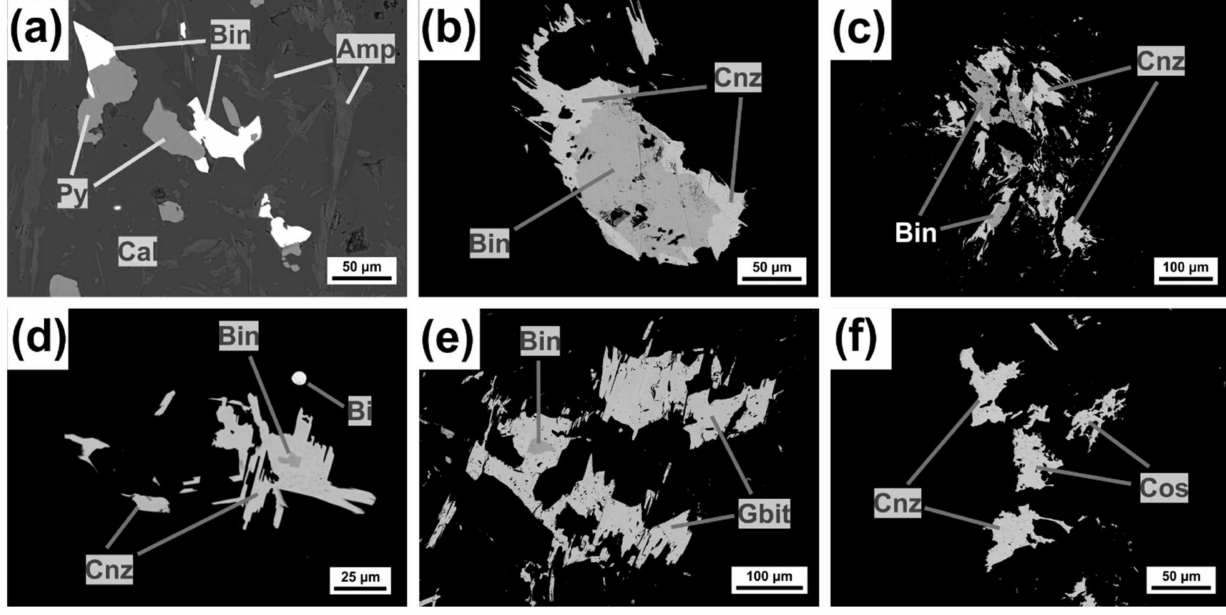
Figure 16. Back-scattered electron (BSE) images showing Bi sulfosalts from the Kizhnica hornfels: ( a ) bismuthinite overgrowing pyrite aggregates in hornfels matrix composed of calcite and amphibole; ( b ) cannizzarite overgrowing bismuthinite; ( c ) aggregate of cannizzarite with bismuthinite; ( d ) euhedral cannizzarite crystal with bismuthinite in the center and disseminated native bismuth droplet; ( e ) galenobismutite euhedral crystals with bismuthinite; ( f ) cosalite and cannizzarite crystals. Abbreviations: Amp = amphiboles; Bi = native bismuth; Bin = bismuthinite; Cal = calcite; Cnz = cannizzarite; Cos = cosalite; Gbit = galenobismutite; Py =